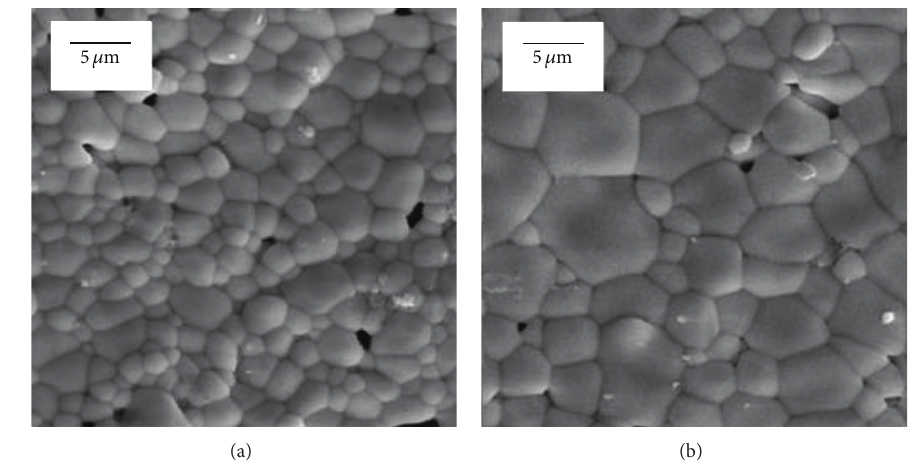
Figure 6: SEM images of the samples C450 (a) and C600 (b).